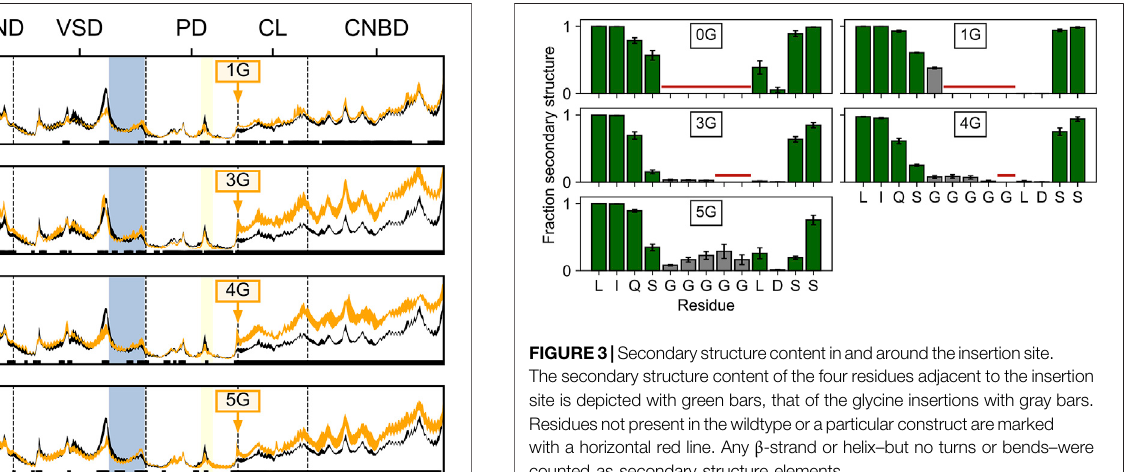
Frontiers in Physiology |